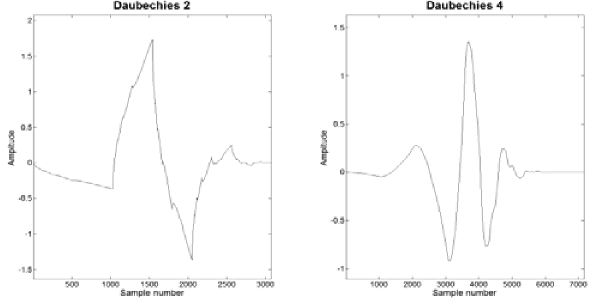
Fig. 8. Daubechies 2 and 4 mother wavelets